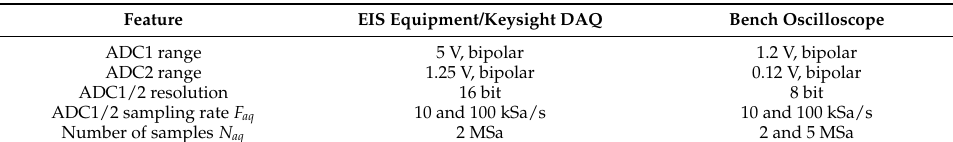
Table 2. Settings of the data acquisition system.